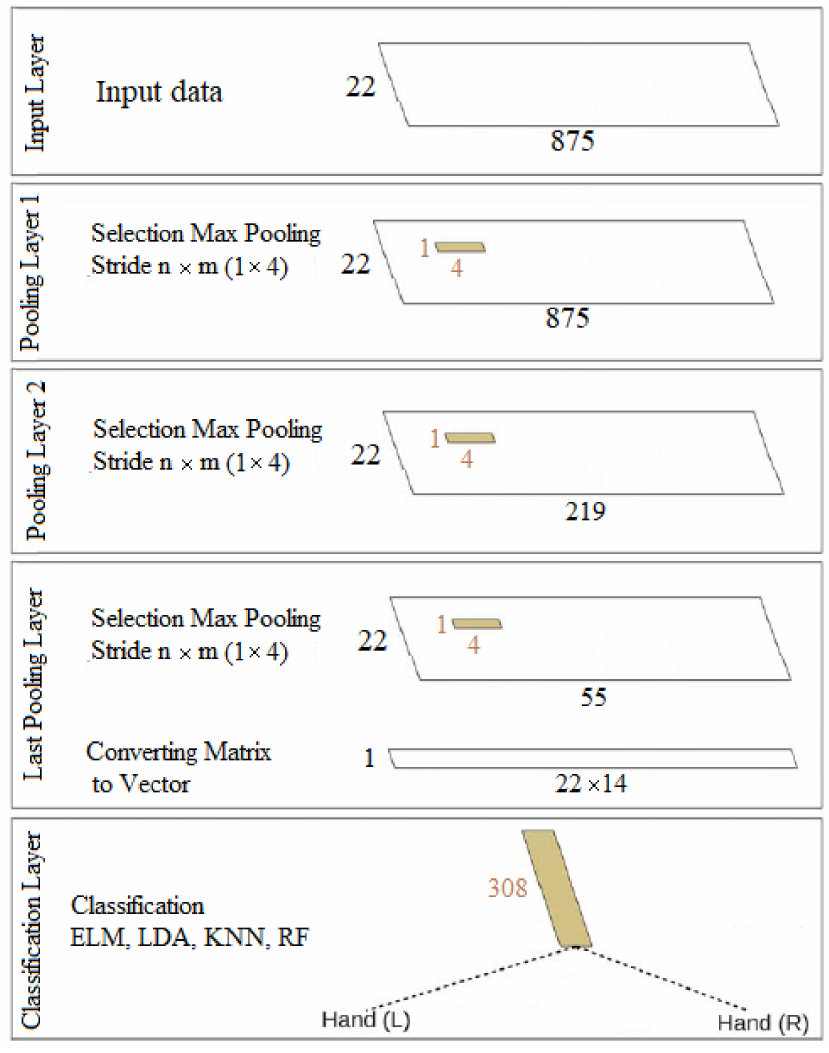
Figure 5. The steps of sampling in different layers using